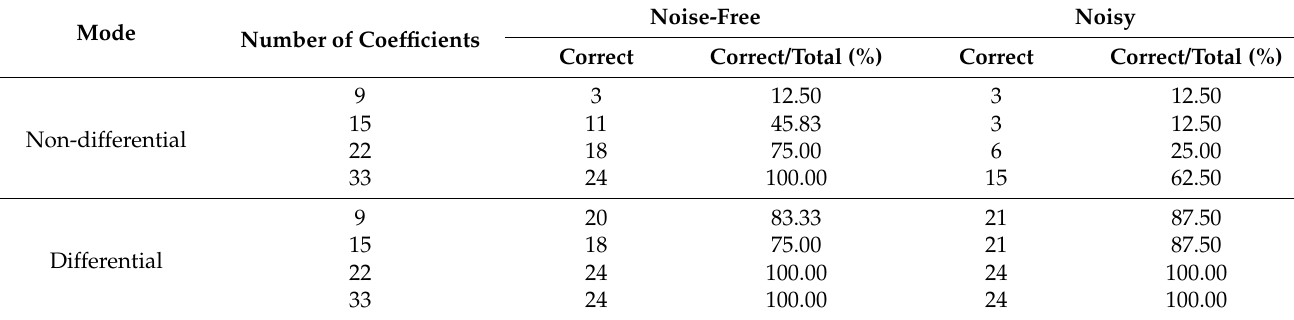
Table 2. Experiment classification results of 24 static